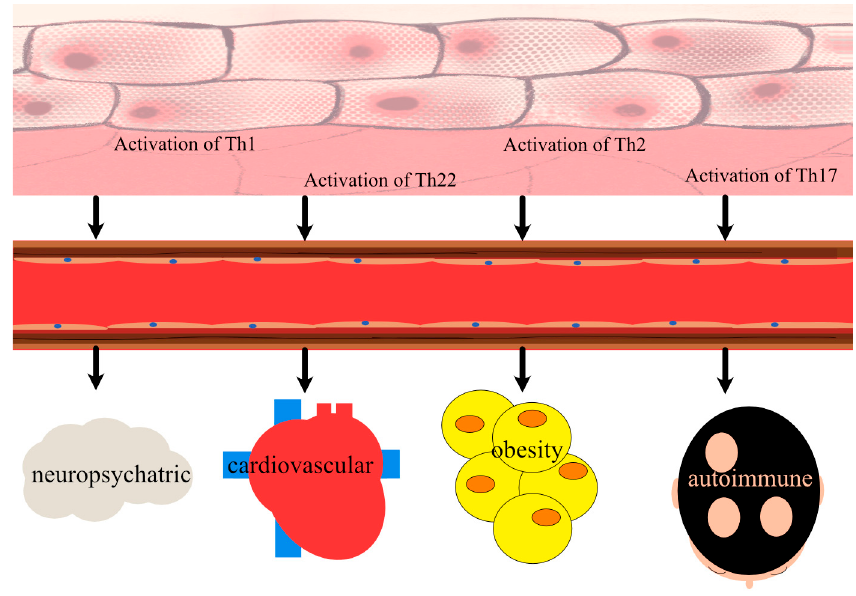
Figure 1. Comorbidities frequently associated with atopic dermatitis (AD). Even though AD is a skin disease, more is known about the co-occurrence of AD-related comorbidities that do not necessarily affect only the skin. The relationship between AD and comorbidities is likely to be bidirectional and complex. This list, however, is not exhaustive, and increasingly more diseases with a higher incidence among AD patients are being